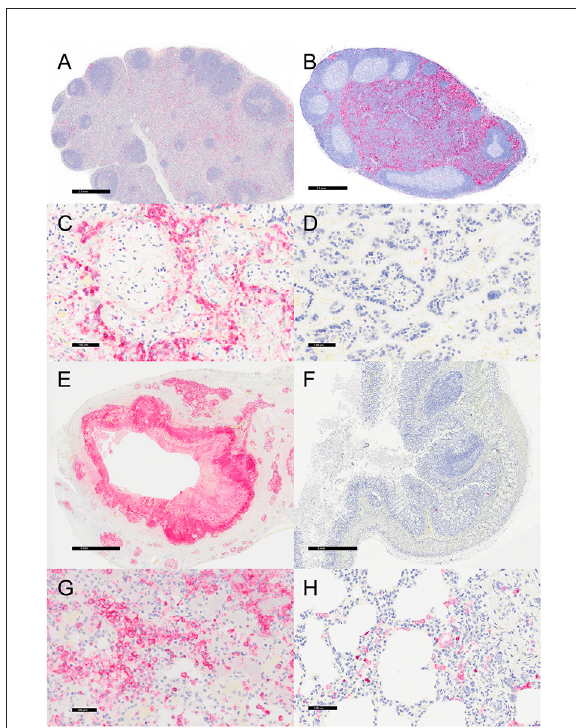
FIGURE5 Immunohistochemistry for CD11c, vervets, multiple organs. (A) Y. enterocolitica- positive vervet, mesenteric lymph node, case 6. Approximately 20% of cells within the lymph node medullary sinus stain positively for CD11c. (B) Control vervet, mesenteric lymph node. CD11c-positive antigen-presenting cells (APCs) make up about 80% of the cells within the cortex and medullary sinuses of the lymph node. (C) Y. enterocolitica- positive vervet, placenta, case 20. CD11c-positive APCs are centered on areas of necrosis and are also increased in maternal blood. (D) Control vervet, placenta. CD11c-positive cells are rare within the control placenta. (E) Y. enterocolitica- positive vervet, colon, case 3. CD11c-positive cells are prevalent within lesions. (F) Control vervet, colon. Two CD11c-positive APCs are present within the colonic mucosa. (G) Y. enterocolitica- positive vervet, lung, case 1. Abundant CD11c-positive cells are found within necrotic lesions. (H) Control vervet, lung. CD11c-positive cells are